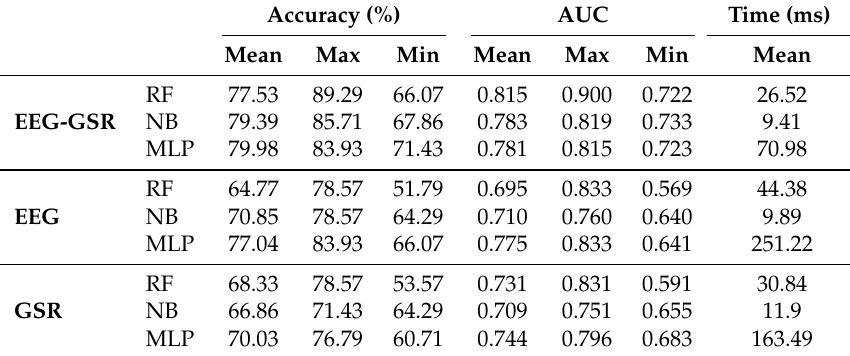
Table 8. Final performance comparison—1000 runs of 10-fold cross